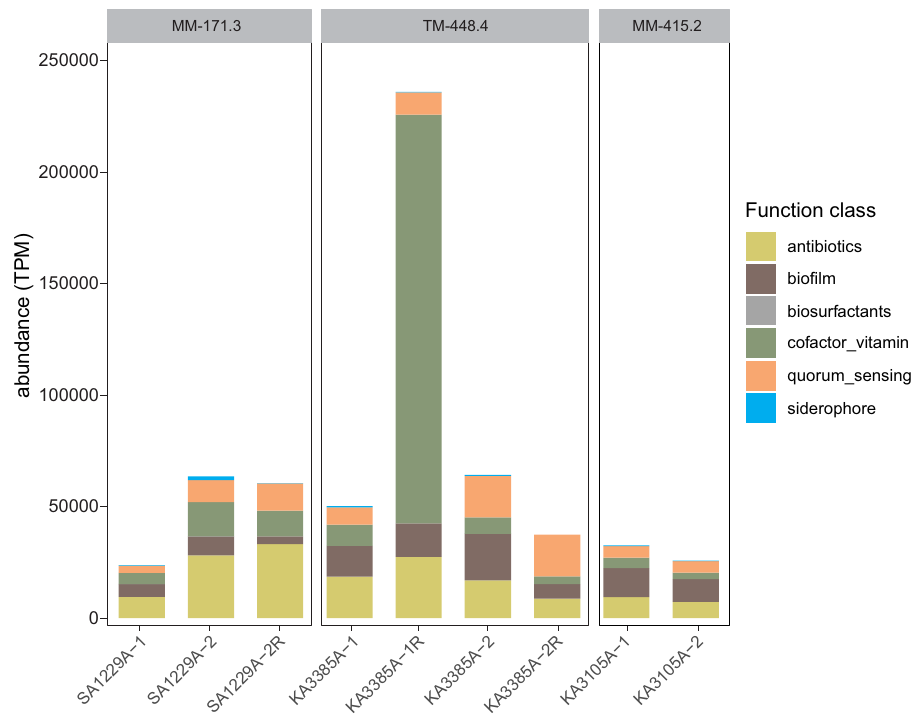
Fig. 6 Expression level of some functional classes involved in public good provision in the sequenced metatranscriptomes. The list of screened K0 identi fi ers is shown in Supplementary Data